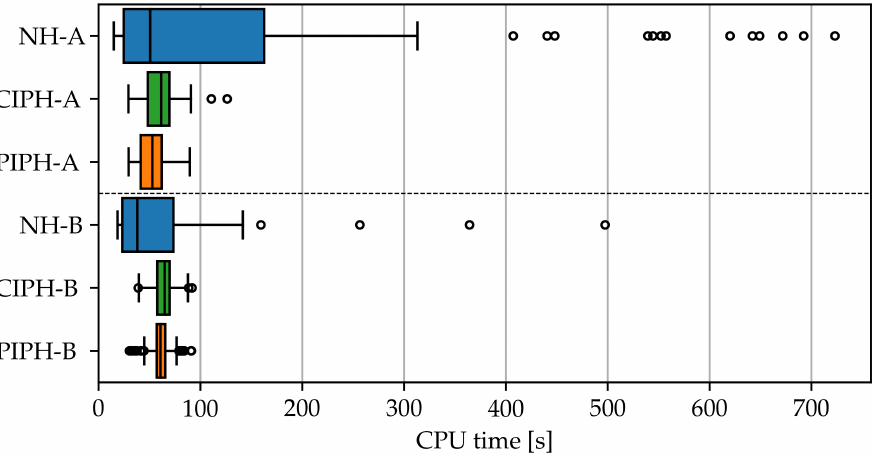
Figure 3. CPU wall time for the NH-, CIPH-, and PIPH-method, obtained by initialization parameter sampling by User A and User